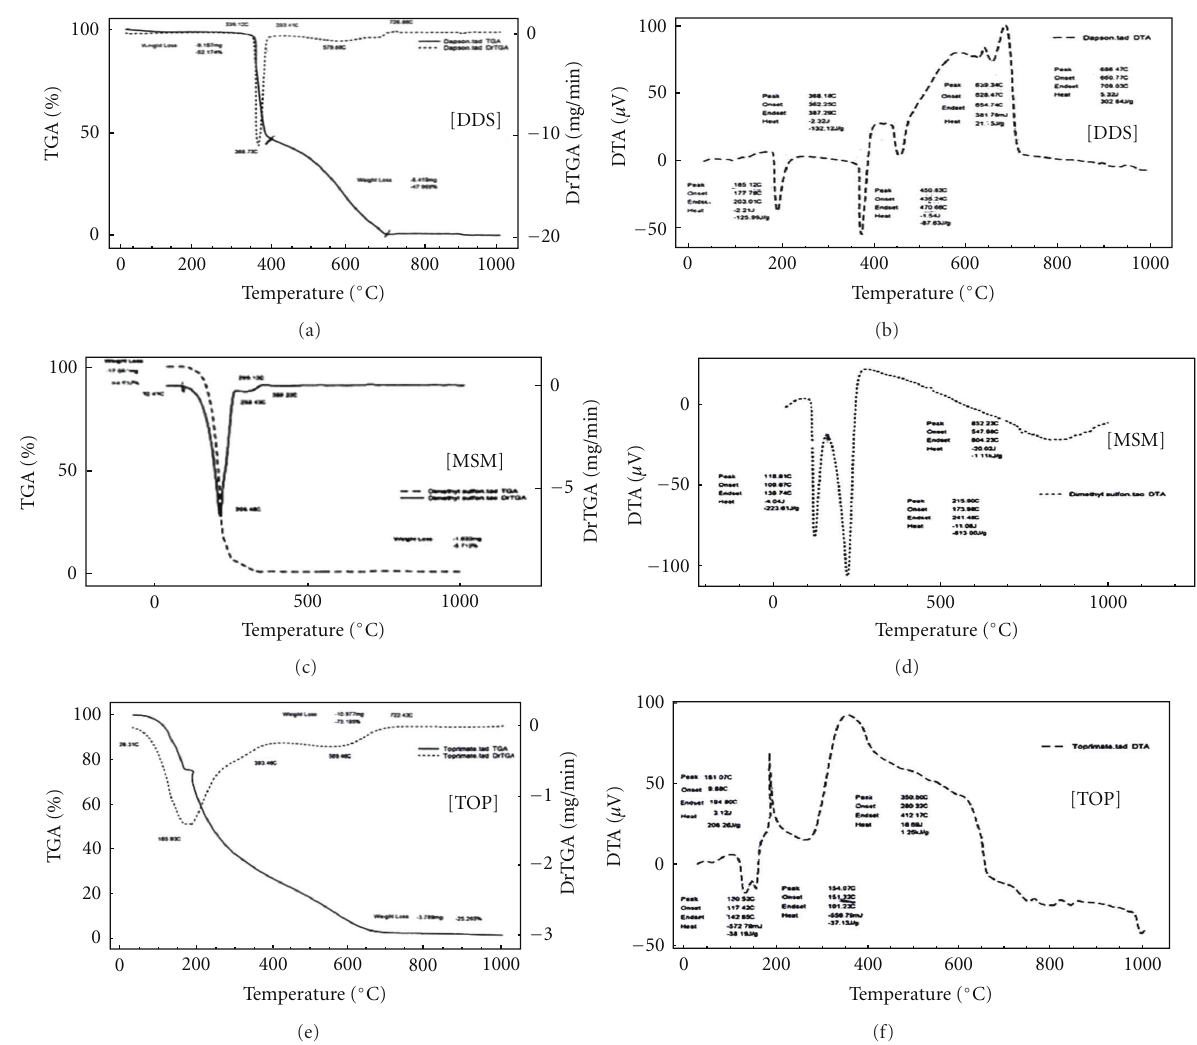
Figure 1: Thermal decomposition TGA/DTG and DTA for Dapsone, dimethyl sulfone, and Topiramate.